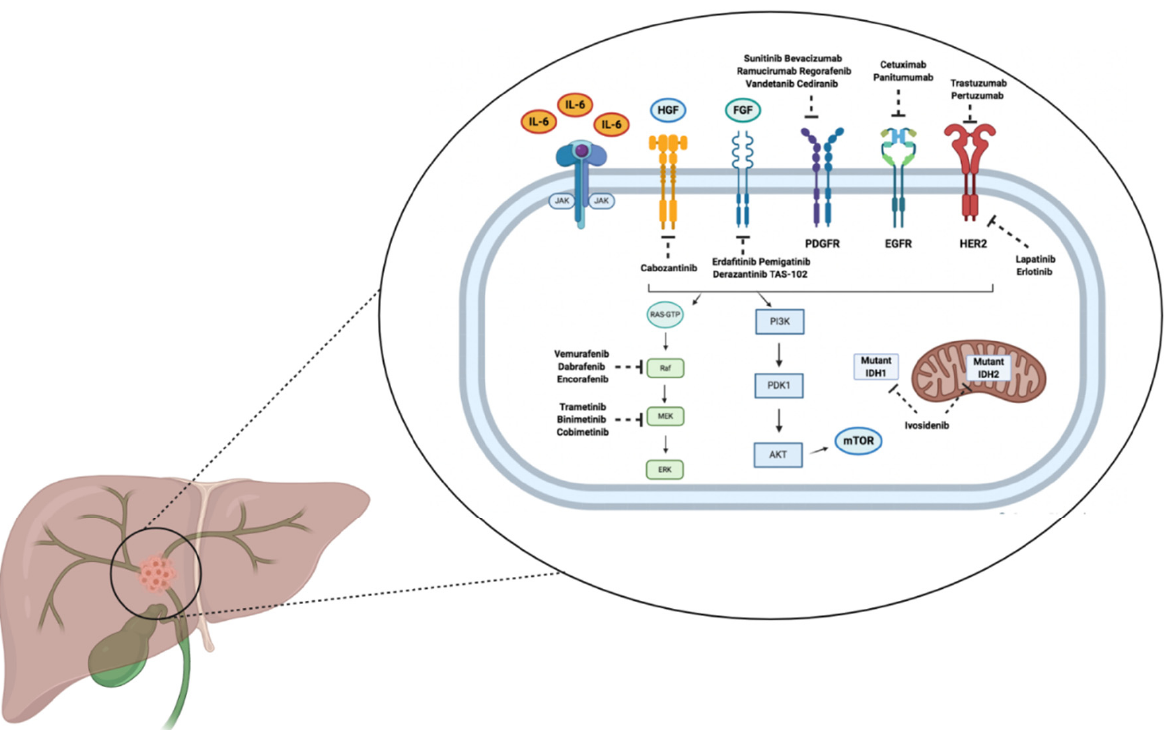
Figure 1. Schematic figure summarizing the main signaling pathways and targeted therapies currently under assessment in biliary tract cancer. Abbreviations: AKT: protein kinase B; EGFR: epidermal growth factor receptor; FGF: fibroblast growth factor; HER2: epidermal growth factor receptor 2; HGF: hepatocyte growth factor; IL-6: interleukin 6; IDH: isocitrate dehydrogenase; JAK: Janus kinase; mTOR: mammalian target of rapamycin; PDGFR: platelet-derived growth factor receptor; PDK1: phosphoinositide-dependent kinase-1; PI3K: phosphoinositide 3-kinase.